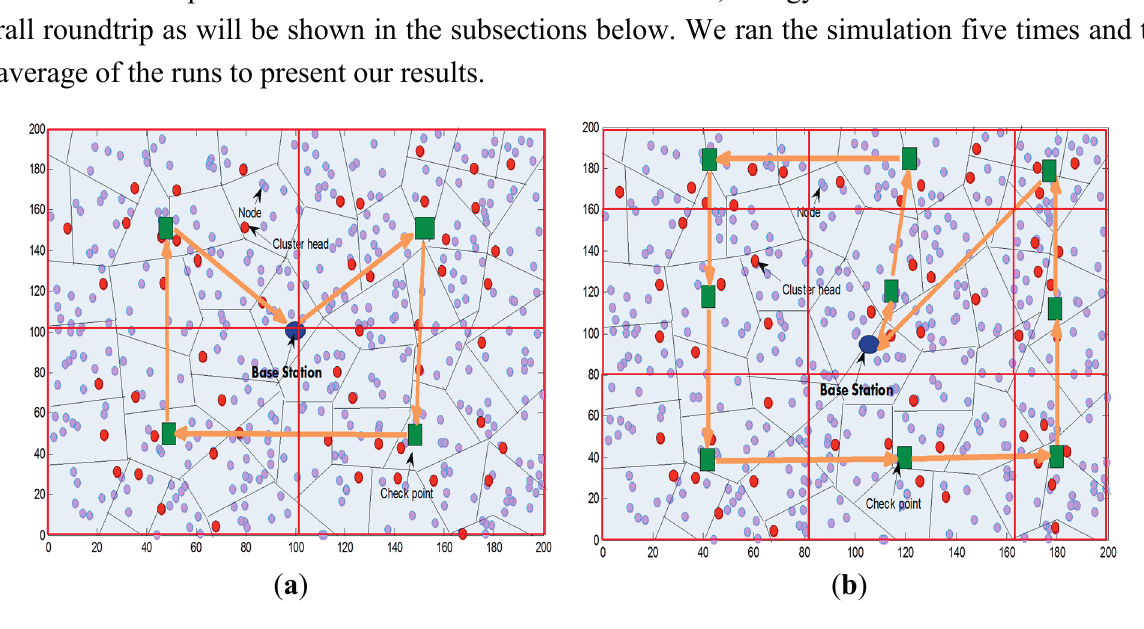
Figure 2. ( a ) Path of the ferry where four checkpoints are used; ( b ) Paths of the ferry with checkpoints, where nine checkpoints are